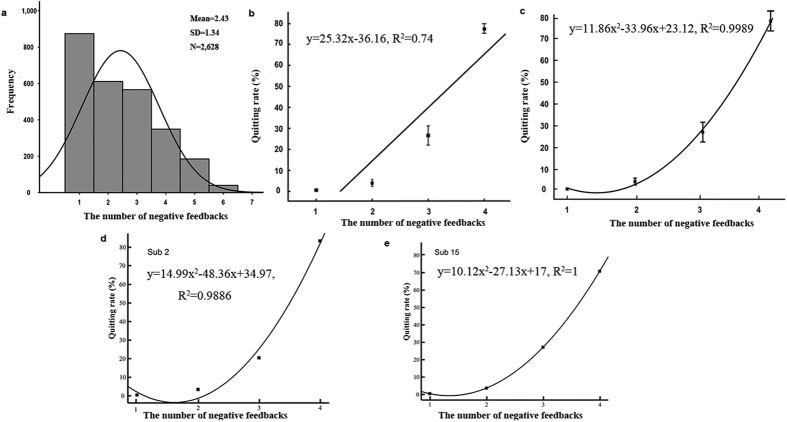
Behavioral results.(a) The coverage of choosing to continue. (b,c) A linear regression (b) and a quadratic polynomial (c) function between the number of negative feedbacks and quitting rate. (d,e) The relationship between the number of negative feedbacks and quitting rate using a quadratic polynomial function in two representative subjects.